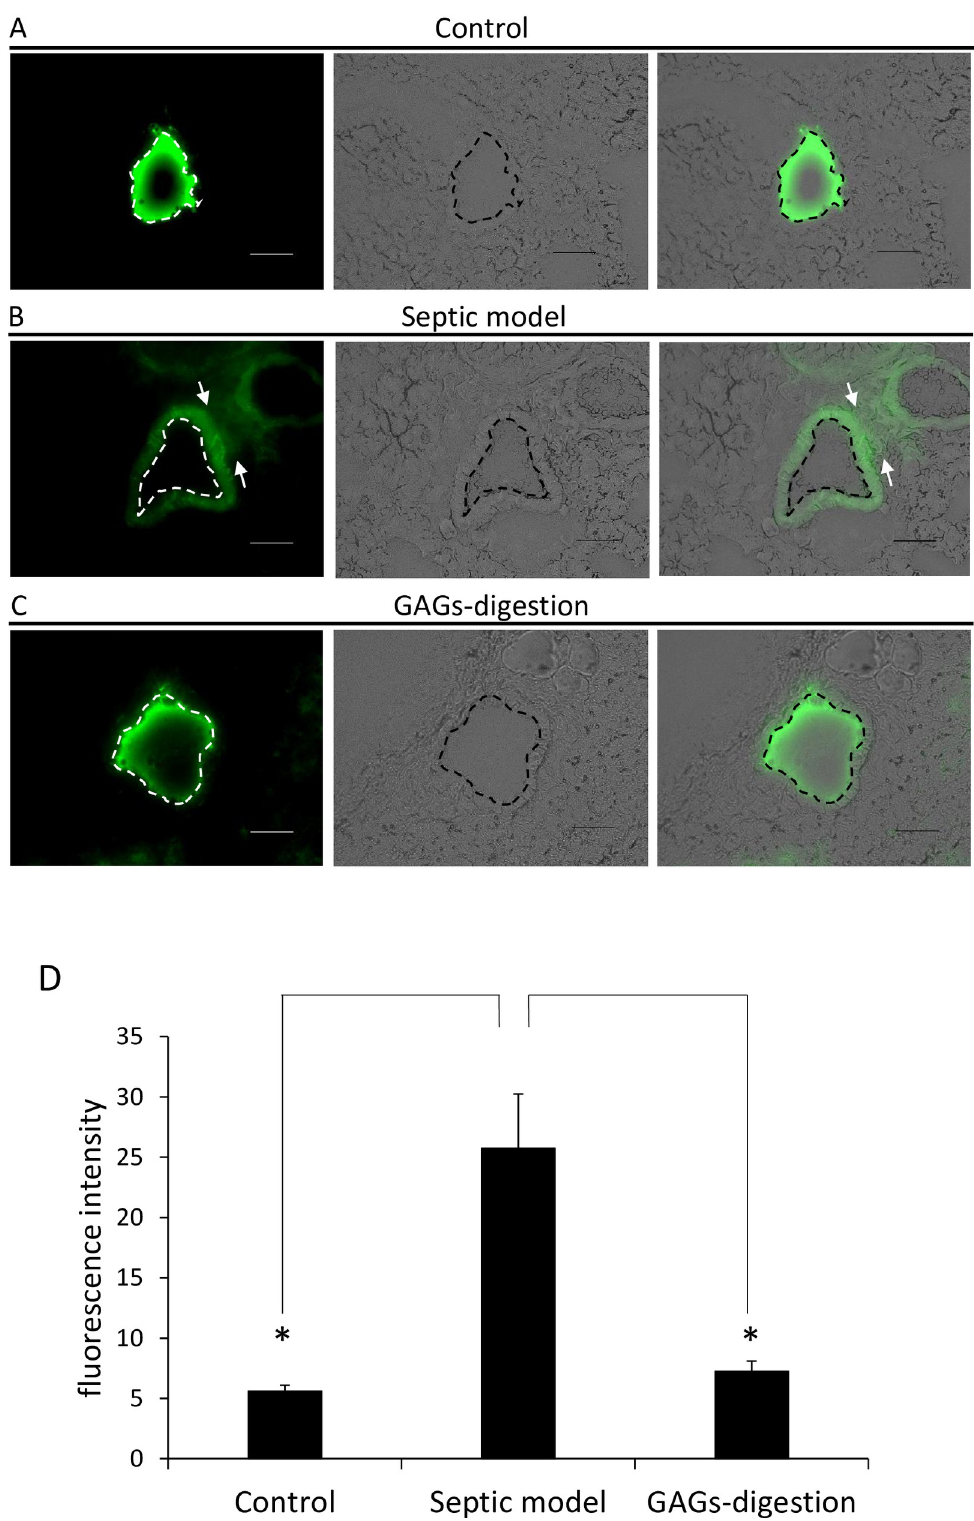
Fig 2. Vascular permeability in the lung after lipopolysaccharide (LPS) administration or enzyme administration. (A) Fluorescence images of lung tissue after FITC-labeled dextran administration via the tail vein in control mice.